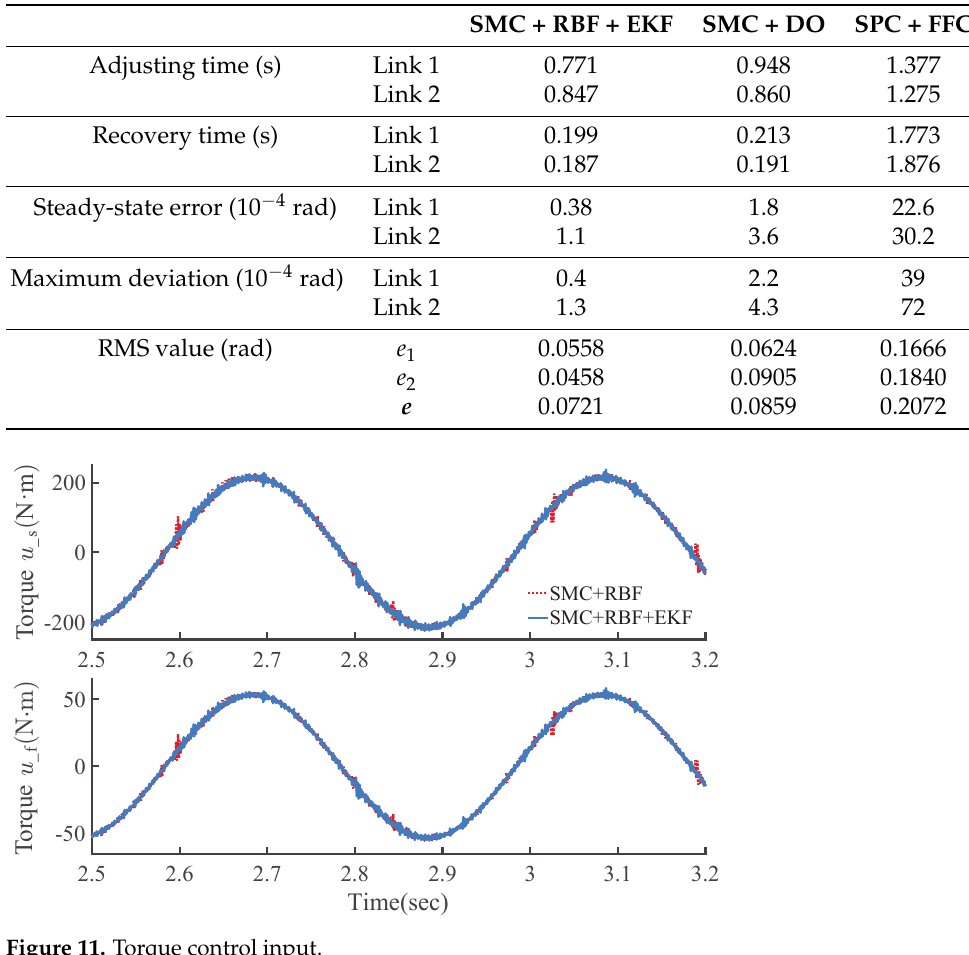
Figure 11. Torque control input.